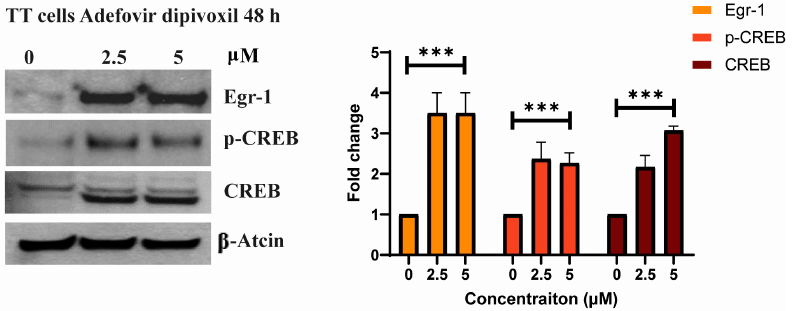
Figure 4. The effects of adefovir dipivoxil on the Egr-1 expression and CREP pathways in TT cells. The levels of Egr-1, CREB, and pCREB were determined by western blotting following 48-h incubation of TT cells adefovir dipivoxil. The western blotting results for Egr-1, p-CREB, and CREB were quantified by densitometric analysis with normalization to basal expression, and differences among groups were analyzed using one-way ANOVA ( n = 3; *** p ≤ 0.001). The uncropped blots are shown in Figure S4.